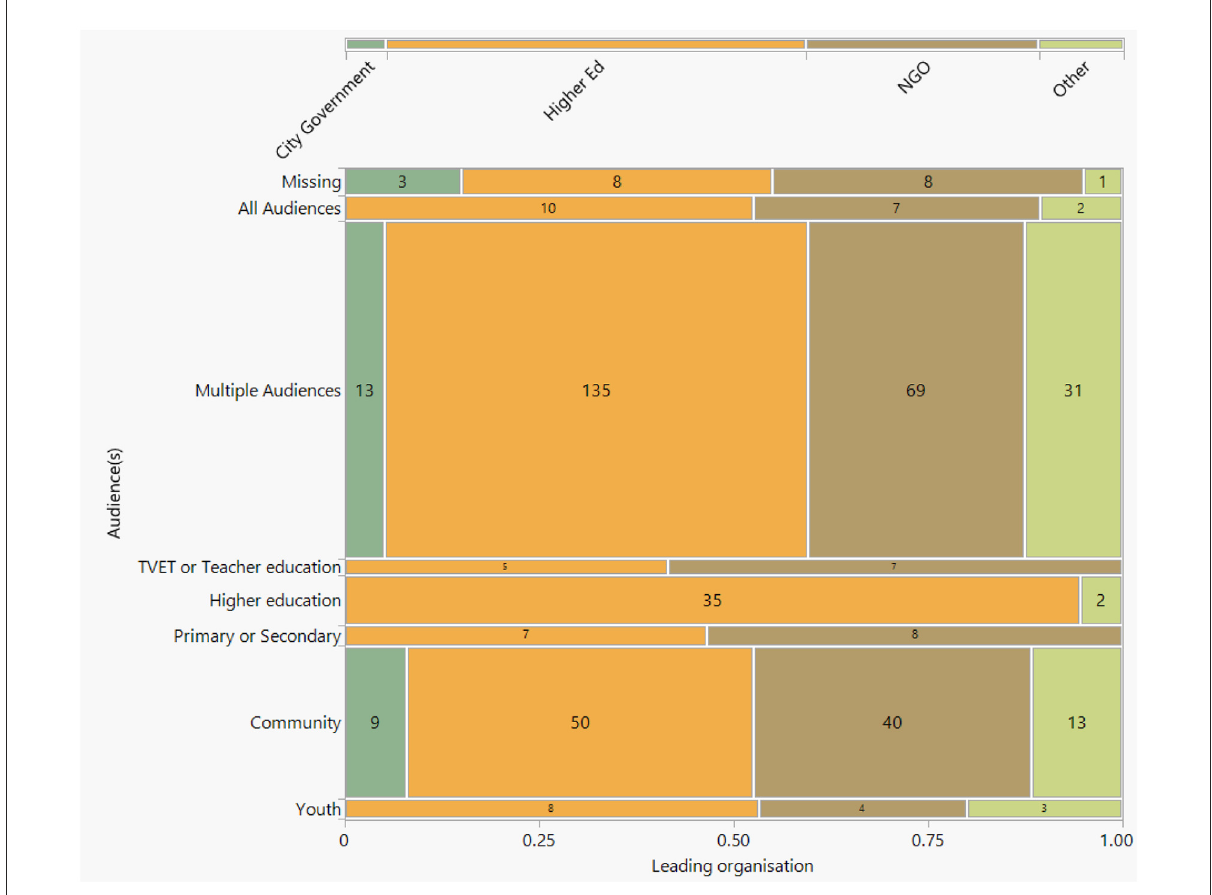
FIGURE10 Educational audience targeted by leading